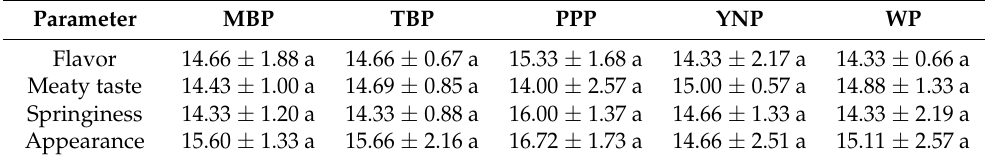
Table 6. Sensory evaluations of the five types of